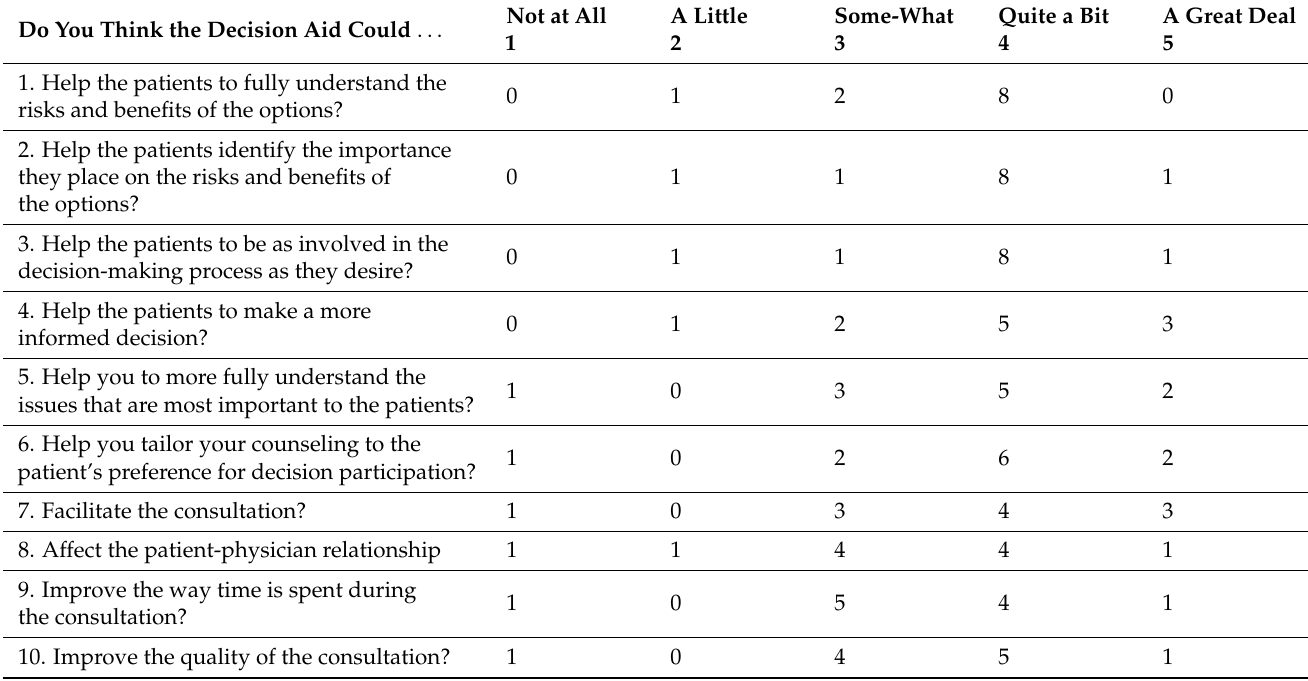
Table A2. Preparation for decision making for